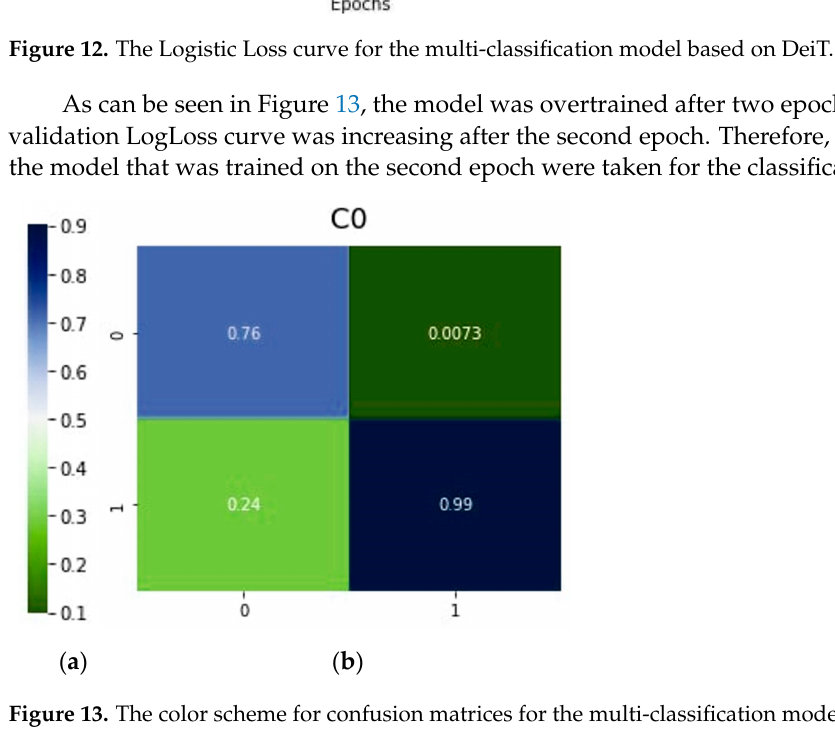
Figure 12. The Logistic Loss curve for the multi-classification model based on DeiT.